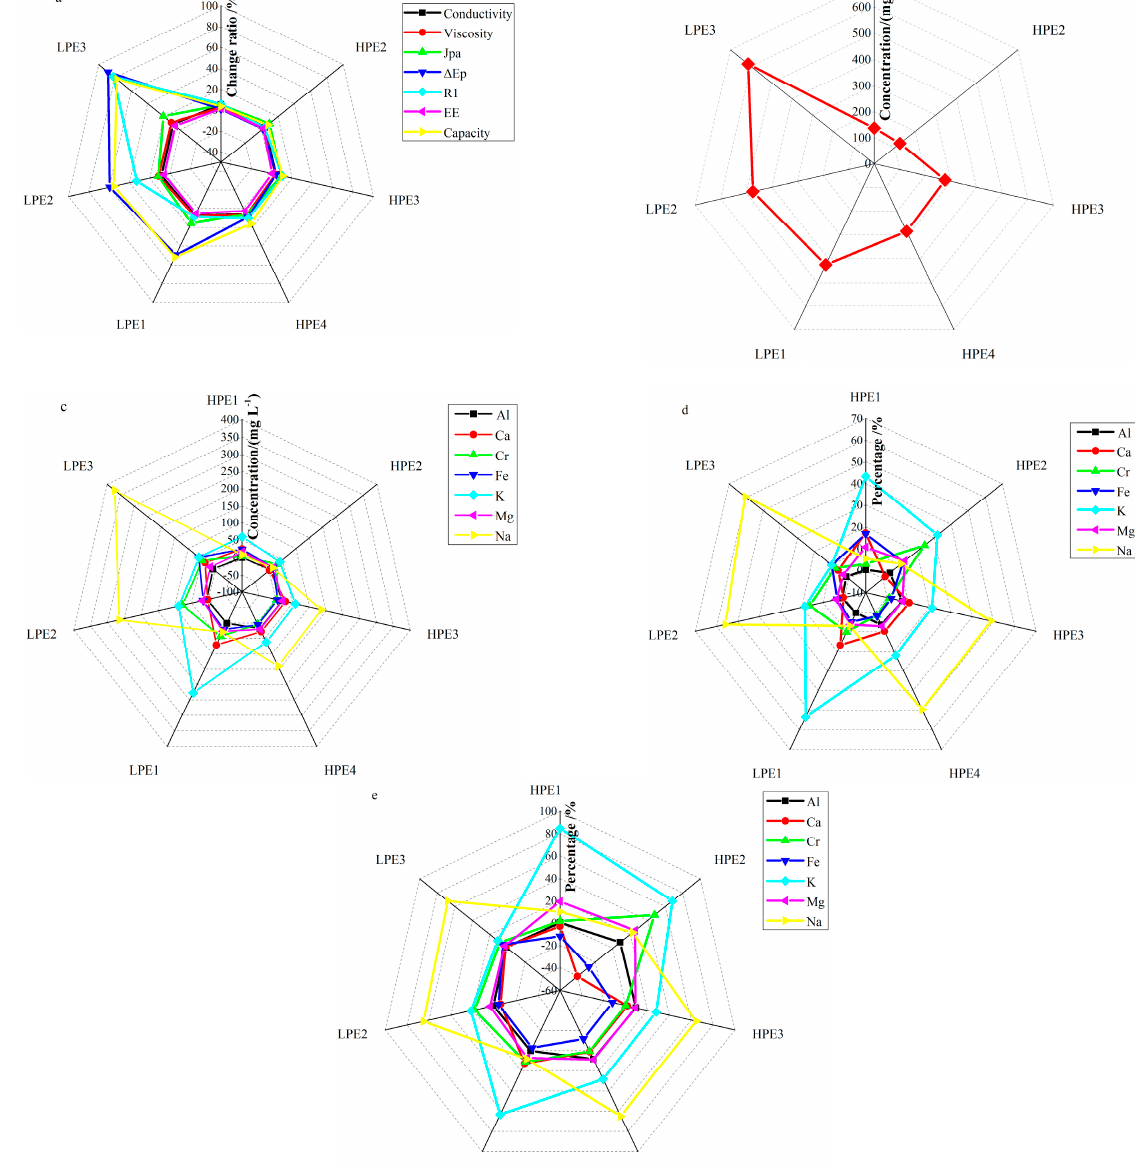
Figure 8. The changing trends of performance and impurities concentration of the electrolyte samples. ( a ) The performance change ratio, ( b ) the total impurities concentration, ( c ) the impurity concentration, ( d ) the percentage of ion concentration to total impurities concentration, ( e ) the relative change percentage of impurity concentration.